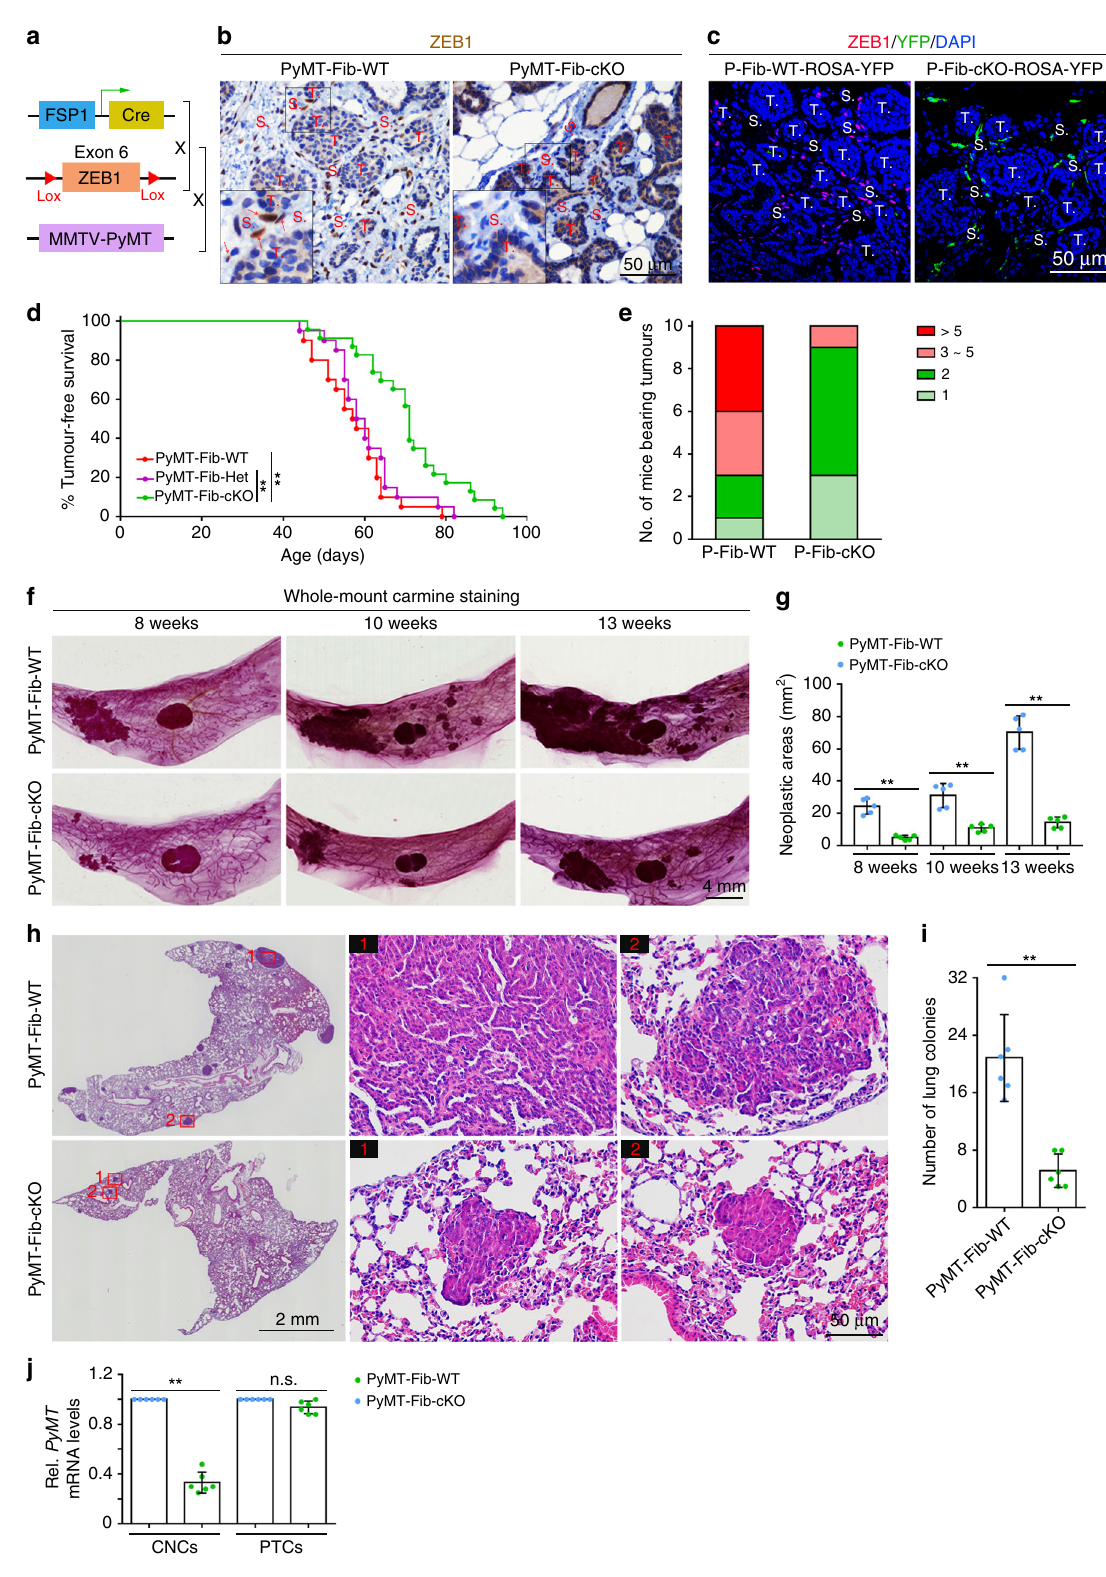
Matrigel, while mammary stromal ZEB1 fl / fl CAFs were seeded in ZEB1-deleted CAFs (i.e., adeno-Cre-infected cells) compared the lower chambers and cultured in medium supplemented with with control CAFs (i.e., adeno- β Gal-infected cells) at 18 and 24 h 10% FBS. Remarkably, we found that the invasion of PyMT- of culture (Fig. 4d, e). To test whether this reduced invasion of cancer cells was signi fi cantly inhibited in the presence of PyMT-cancer cells was due to the proliferation de fi ciency in the NATURE COMMUNICATIONS| (2019) 10:3210